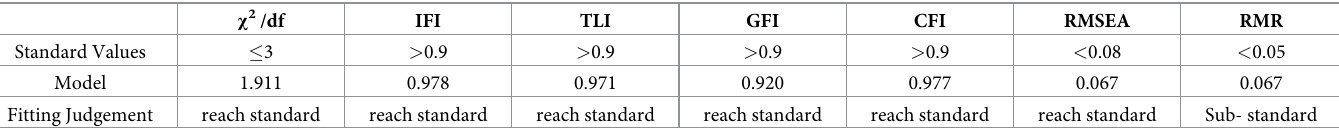
Table 9. Goodness-of-fit index of model.